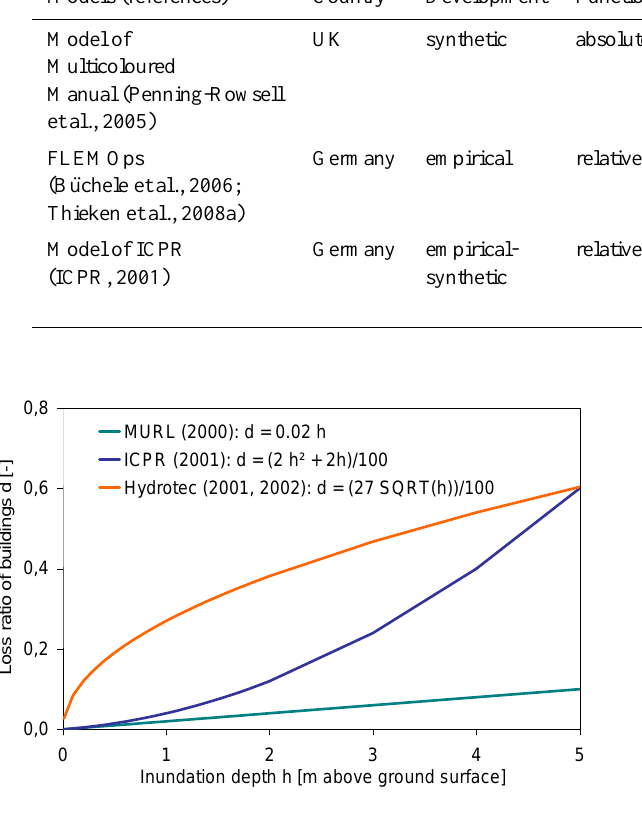
Fig. 2. Examples of depth-damage-curves for the residential sector typically used in